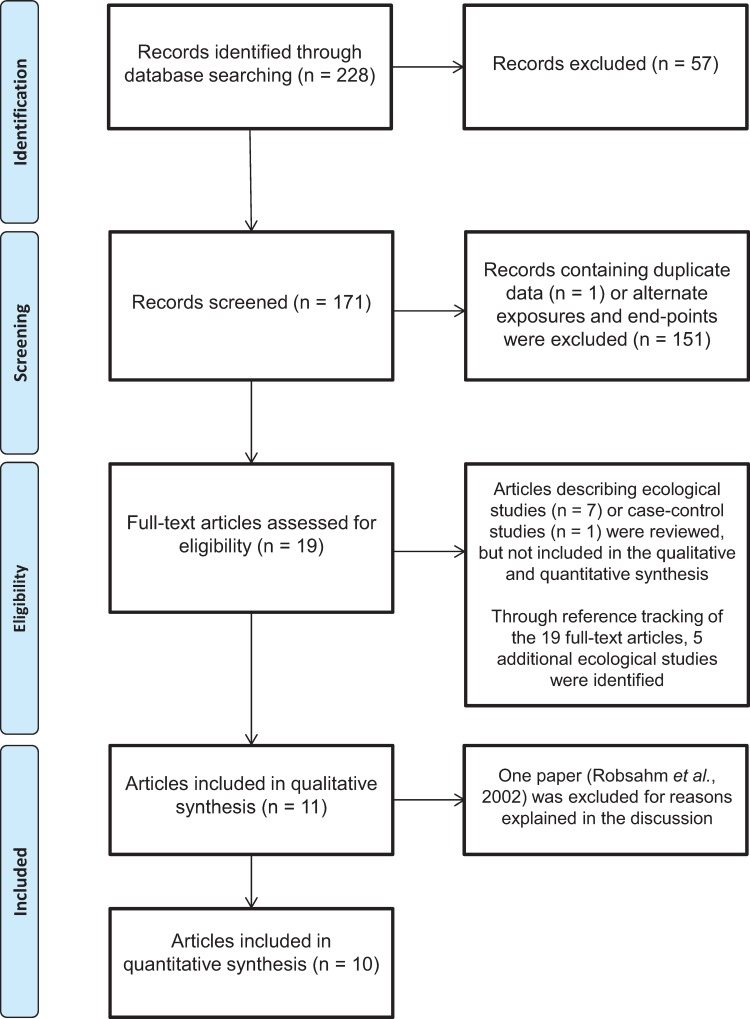
PRISMA flow diagram showing a breakdown of the study selection.